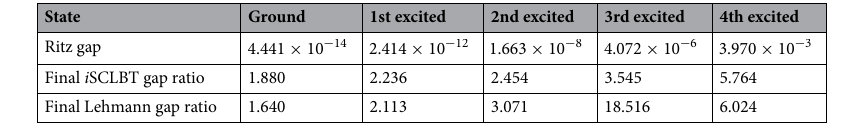
Table 1. Ritz gaps and the final i SCLBT and Lehmann gap ratios at L ∗ = 5 calculated at L = 106 for the Hubbard